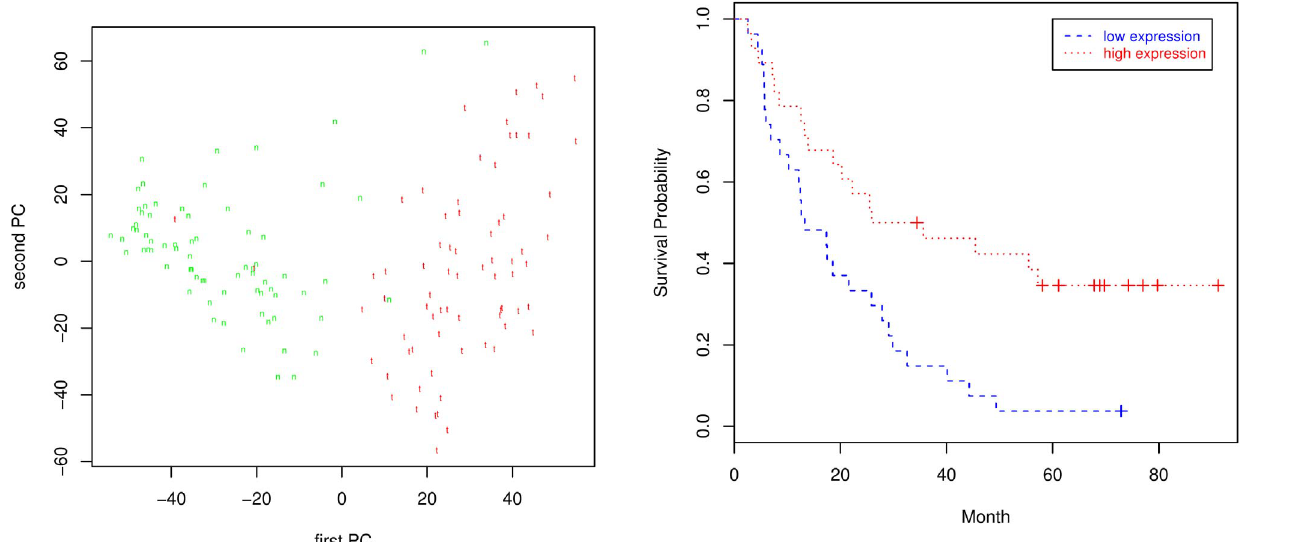
Figure 5. Survival curve for MMP9 in GCA by Kaplan-Meier analyses. Dotted red lines indicate high (above the median) expression and broken blue lines indicate low (below the median)